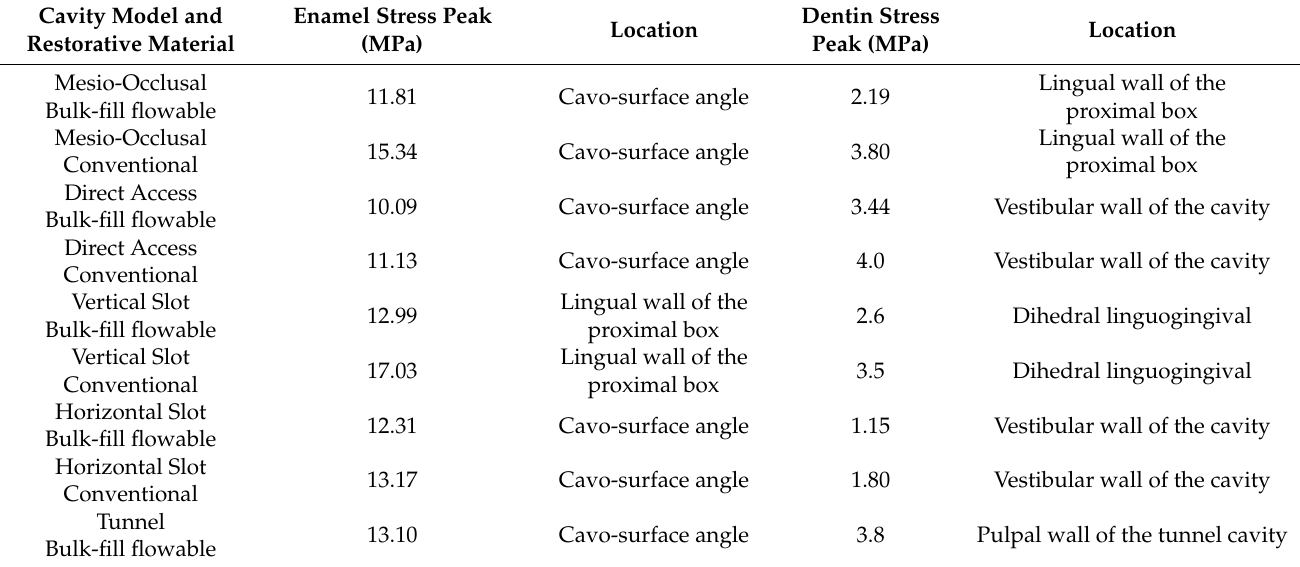
Table 3. Stress peaks (MPa) during polymerization shrinkage measured in enamel and dentin tissue and the respective locations in the cavities.